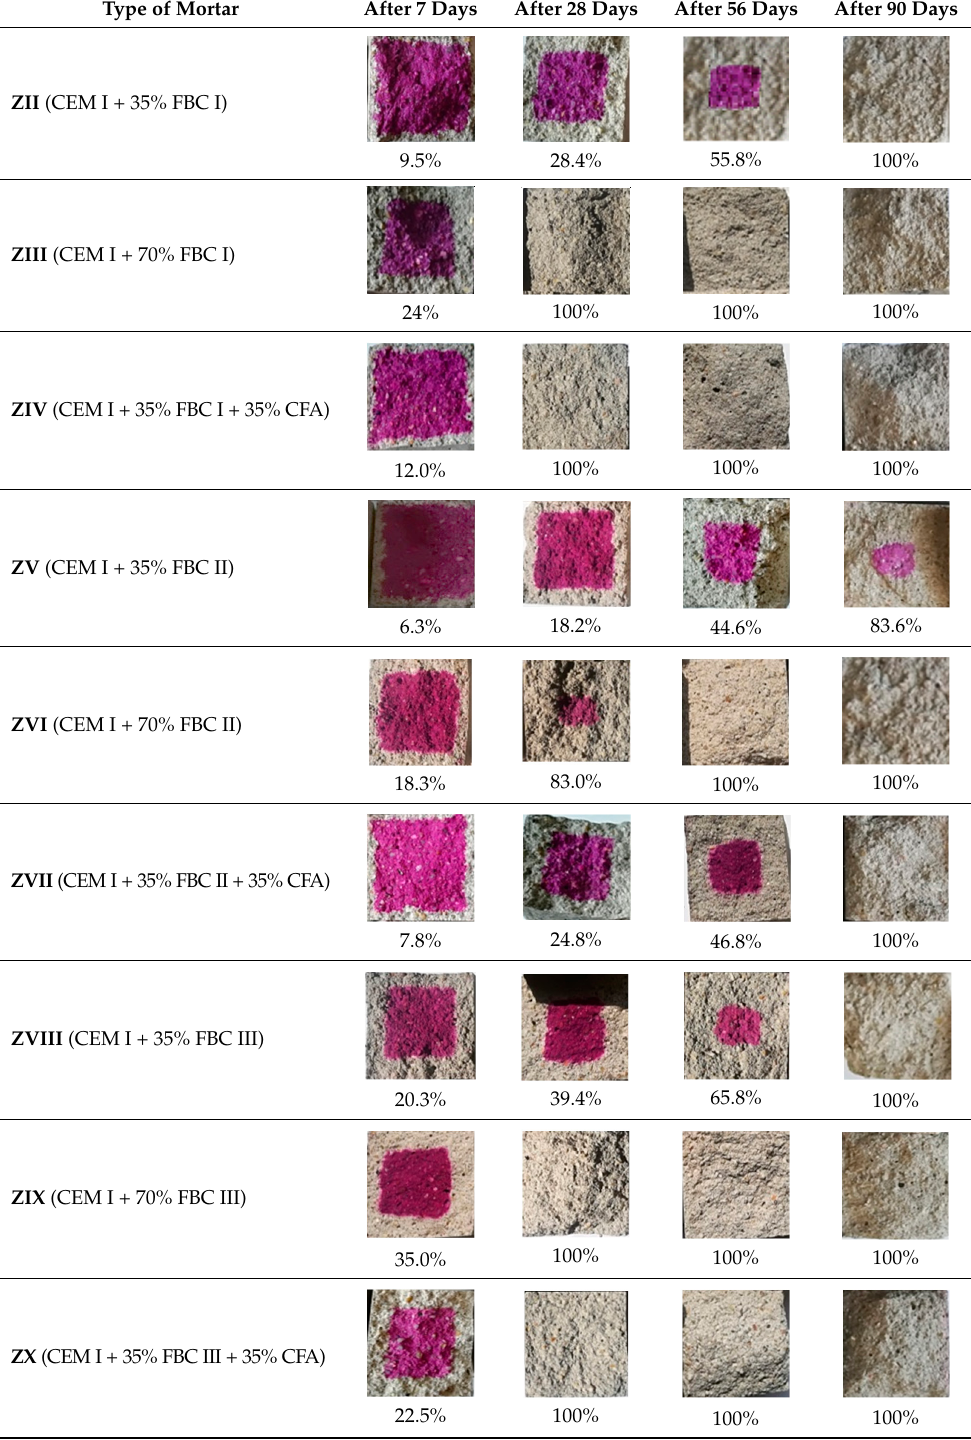
Table 4. Surfaces of mortars containing FBC I, FBC II and FBC III fly ashes, after testing the car- bonized surface with the phenolphthalein solution.